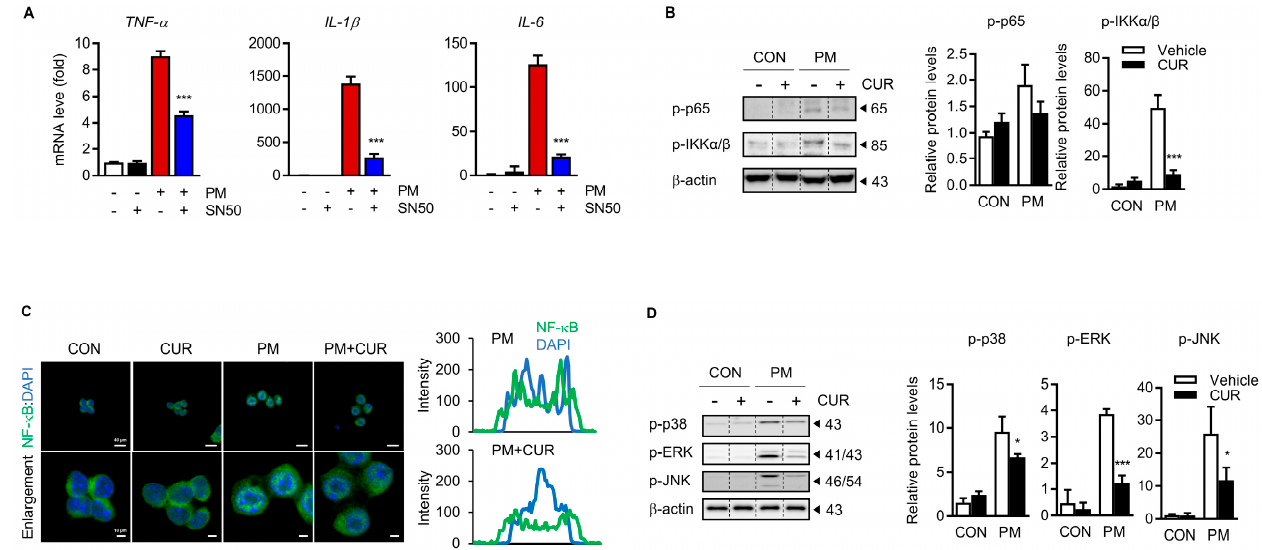
Figure 4. Inhibitory effect of curcumin on PM-induced cytokine production is dependent on MAPK and NF- κ B signaling pathways. ( A ) NF- κ B cell permeable inhibitory peptide (SN50) inhibits translo- cation of NF- κ B and production of inflammatory cytokines. RAW264.7 cells were pretreated for 1 h with 10 µ M of SN50, an inhibitor of NF- κ B, and then treated for 6 h with 20 µ g/mL of PM. mRNA levels of TNF- α , IL-1 β , and IL-6 were assessed using RT-qPCR. ( B ) Effect of curcumin on PM-induced phosphorylation of NF- κ B and IKK α / β in RAW264.7 macrophages. Activation of NF- κ B was indi- cated by measuring the level of phosphorylation of p65 and IKK α / β via immunoblotting techniques and subsequent quantification of them with the use of ImageJ software. ( C ) Effect of curcumin on PM-induced nuclear translocation of NF- κ B p65 in RAW264.7 macrophages. Confocal imaging shows subcellular distribution of NF- κ B. Images show low- ( upper ; scale bars, 40 µ m) and high-power magnification ( lower ; scale bars, 10 µ m). Spatial profiles of fluorescence intensity of NF- κ B along with DAPI, indicating nuclear DNA. ( D ) Effect of curcumin on PM-induced phosphorylation of MAPKs, including p38, ERK, and JNK, in RAW264.7 macrophages. Data represented as the mean ± SD of three independent experiments. *** p < 0.001, * p < 0.05 vs. PM-treated group. CON, control group; CUR, curcumin; PM, particulate matter.